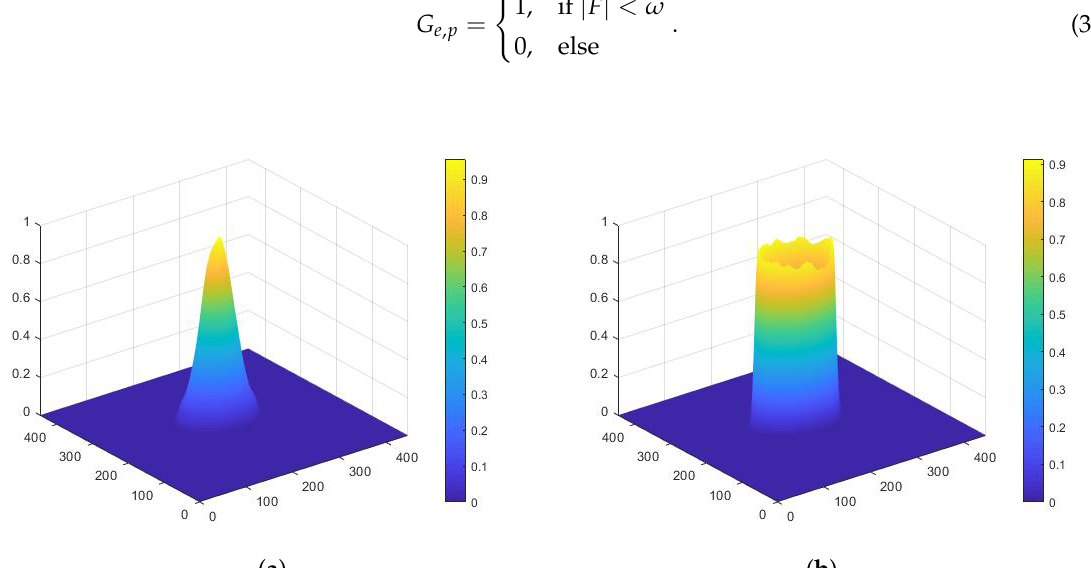
Figure 4. ( a ) Visualization of center intensity in image space; and ( b ) visualization of edge intensity in image